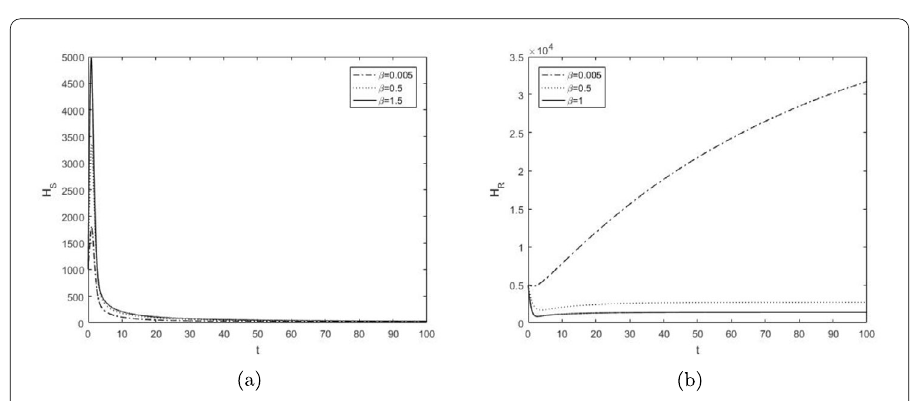
Figure 6 Variation of H S , H R versus t for β = 0.005,0.5,1.5